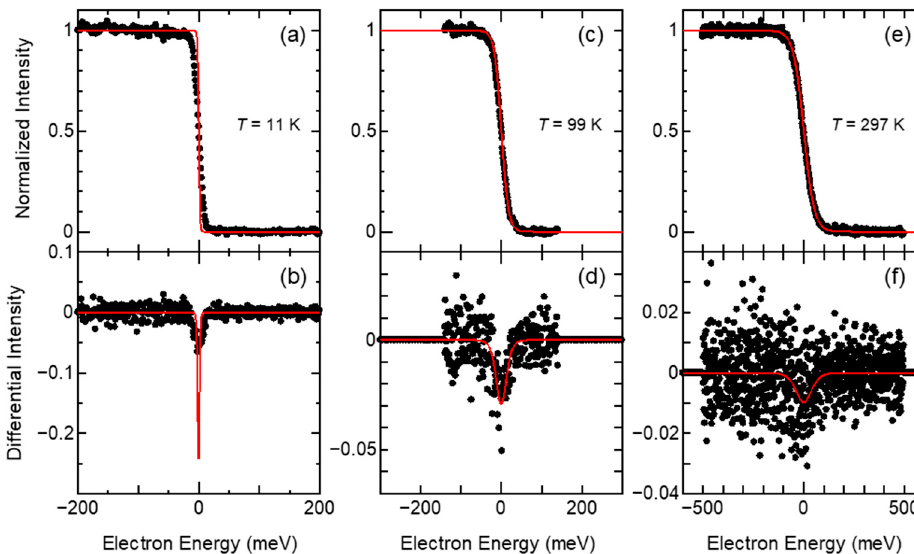
Figure 3. Normalized photoelectron spectra of Au(110) (upper row) and the differential photoelectron spectra (lower row) measured at 11 K ( a , b ), at 99 K ( c , d ), and at 297 K ( e , f ). The FD distribution function at each temperature is shown overlaid on each spectrum (upper row, red), and the differential FD distribution is shown overlaid on each differential spectrum (lower row, red).